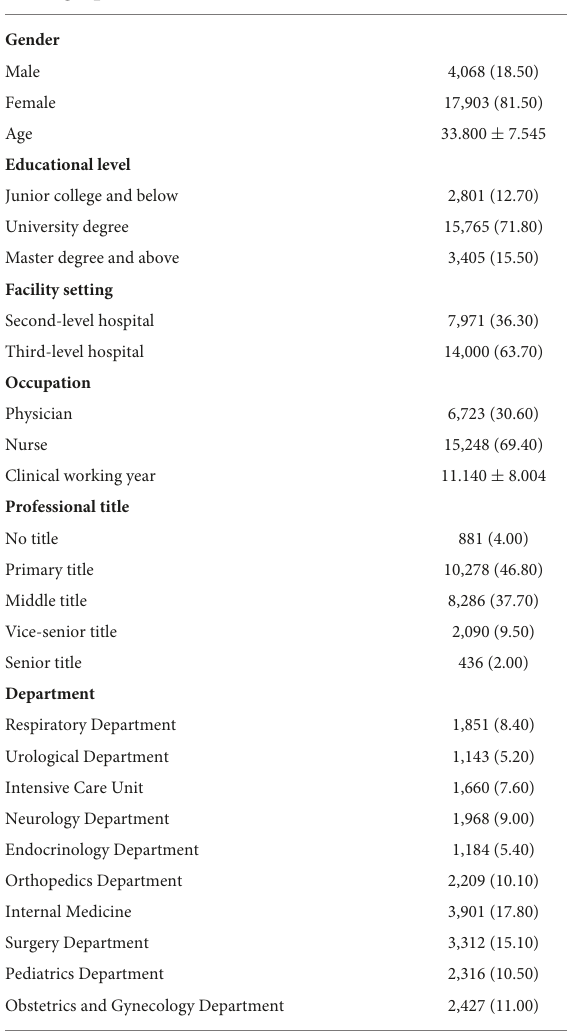
TABLE 1 Demographics of medical staff ( n =